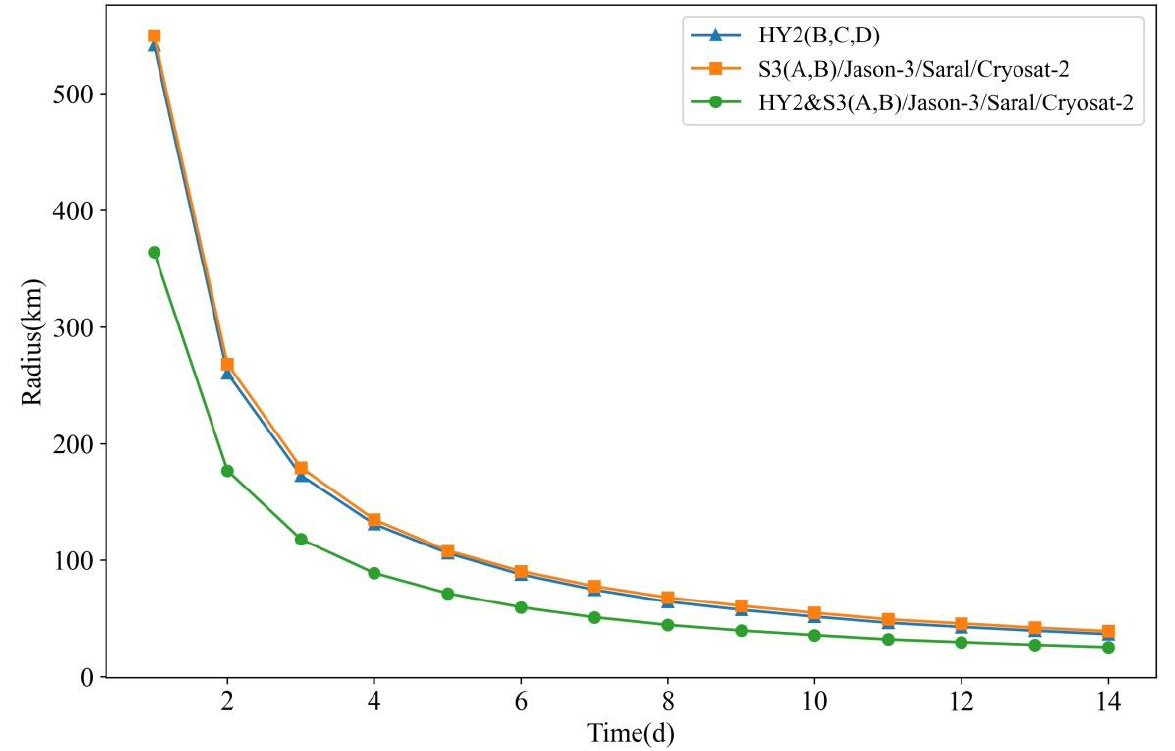
Figure 2. Observation efficiency of radar altimeter constellation.